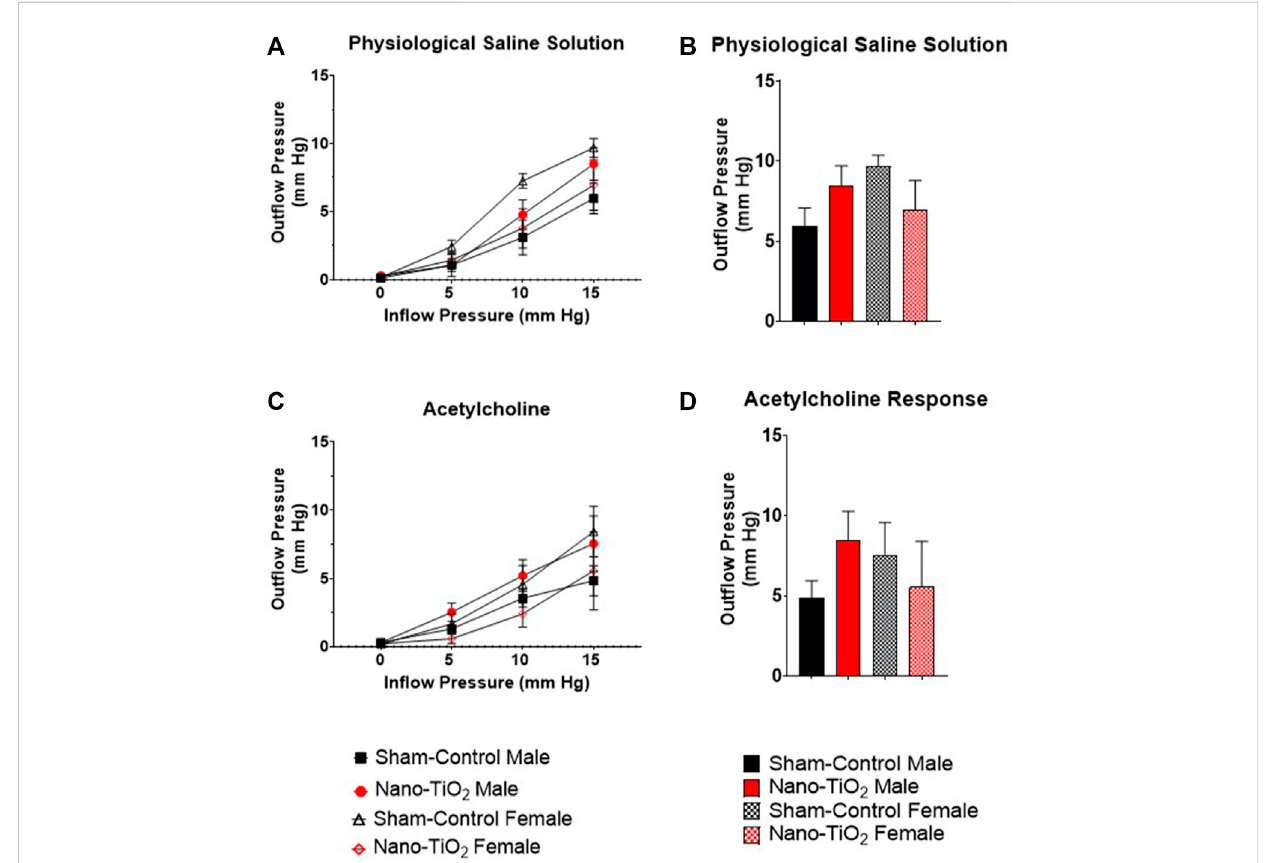
PlacentalOut fl owHemodynamics.Out fl owpressurereadingswererecordedinconjunctionwithincreasedin fl owinput. (A) Out fl owpressureinthe presence of physiological saline solution (PSS). (B) Maximum out fl ow response in the presence of PSS. (C) Out fl ow pressure in the presence of the endothelium-dependent vasodilator, ACh. (D) Maximum out fl ow response in the presence of ACh. Sham-control fetal male, n = 5-6, nano-TiO 2 fetal male, n = 5-7, sham-control fetal female, n = 4-5, and nano-TiO 2 fetal female, n =